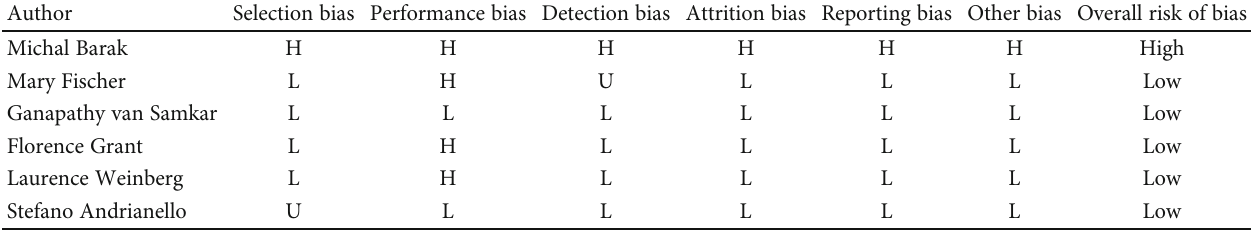
Table 2: Quality assessment of prospective studies using the Cochrane Assessment of Bias Tool.